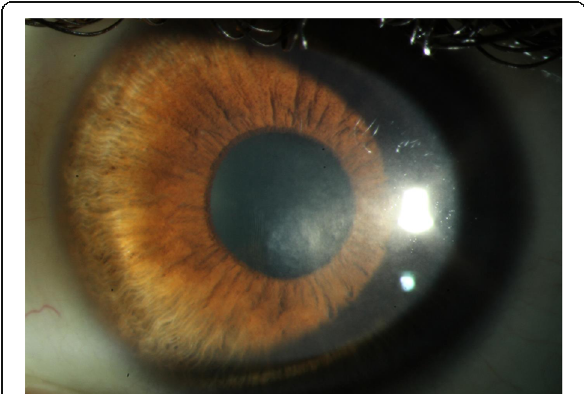
Fig. 1 Slit-lamp photograph of the left eye a few months after initial